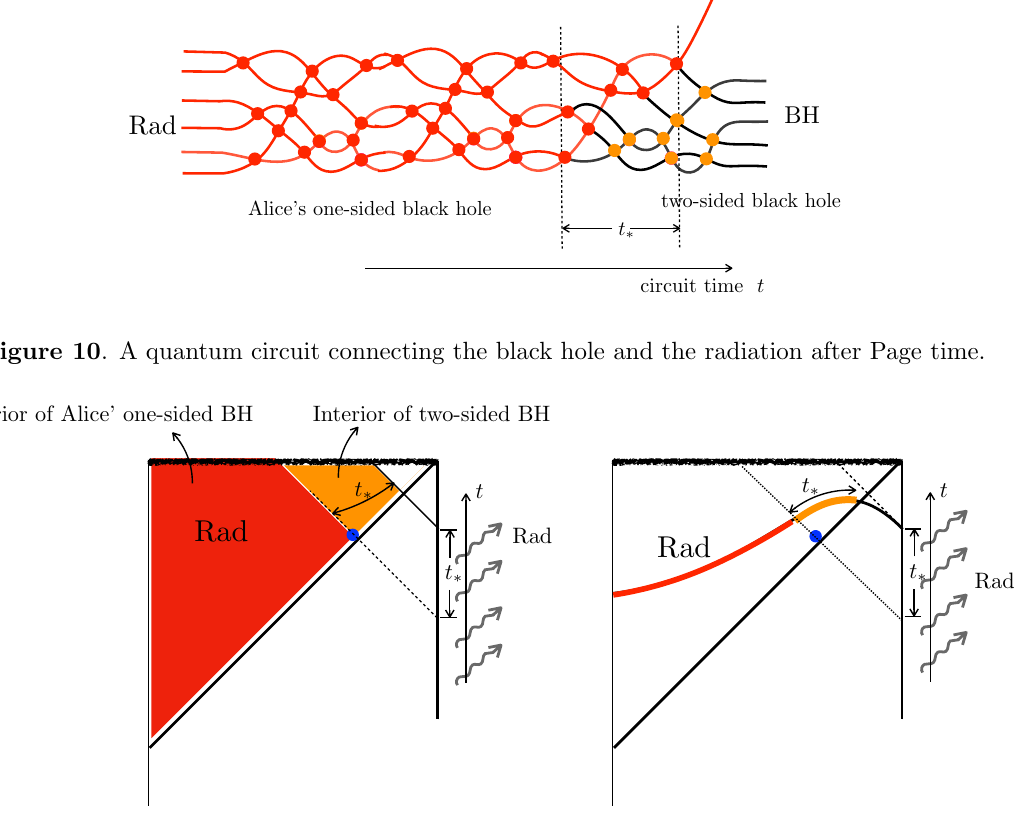
Figure 11 . The blue dot represents the RT